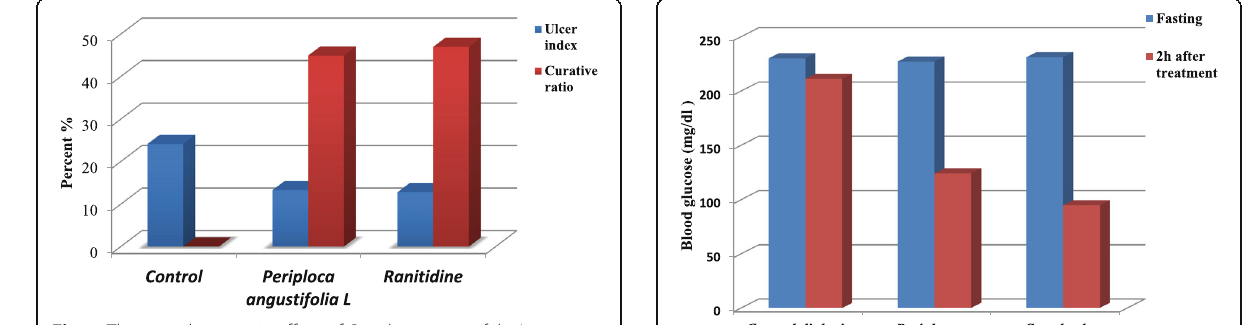
Fig. 4 The anti-ulcerogenic effect of Periploca angustifolia L. on Alcohol -induce ulcer in rats (n =